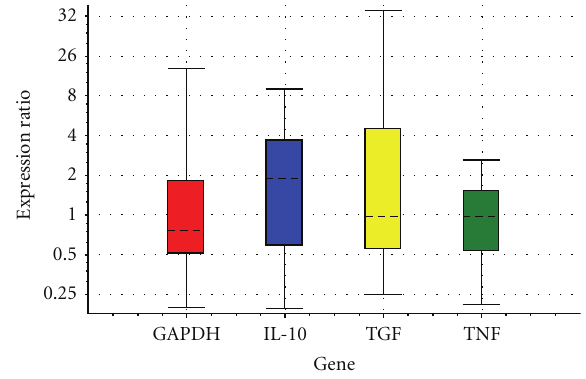
Figure 4: Relative expressions of IL-10, TGF- β 1, and TNF- α ob- tained from ginseng versus control after processing RT-PCR with REST in 40th